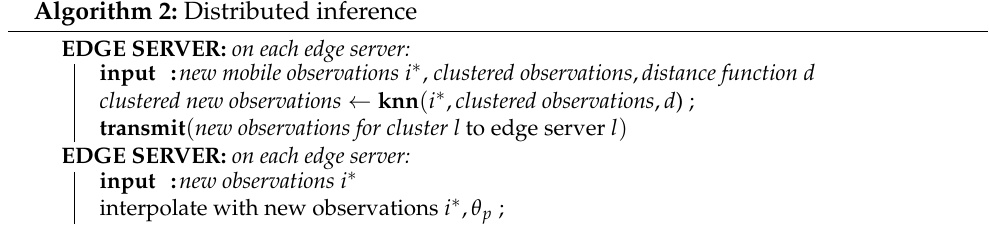
Algorithm 2: Distributed